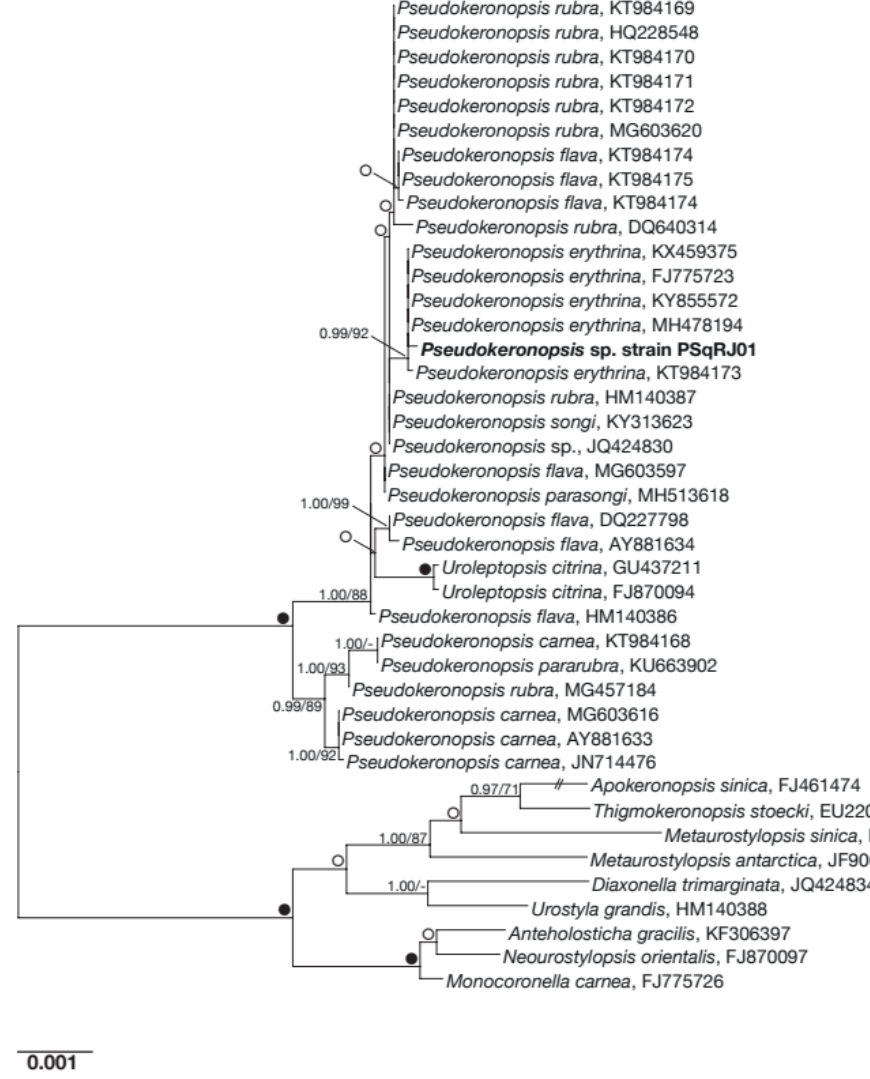
Figure 3. Maximum likelihood tree of the genus Pseudokeronopsis based on 18S rDNA sequences. The phylogenetic position of Pseudokeronopsis cfr. erythrina PSqRJ01 is shown. Numbers associated with nodes represent posterior probability from Bayesian inference (BI) and bootstrap value from maximum likelihood (ML) analyses, respectively (only values of BI ≥ 0.80 and ML ≥ 70% are shown). Black dots represent the highest statistical support (BI = 1.00 and ML = 100); white dots indicate non-significant statistical support (BI < 0.80 and ML < 70%). The sequence obtained in the present work is in bold.